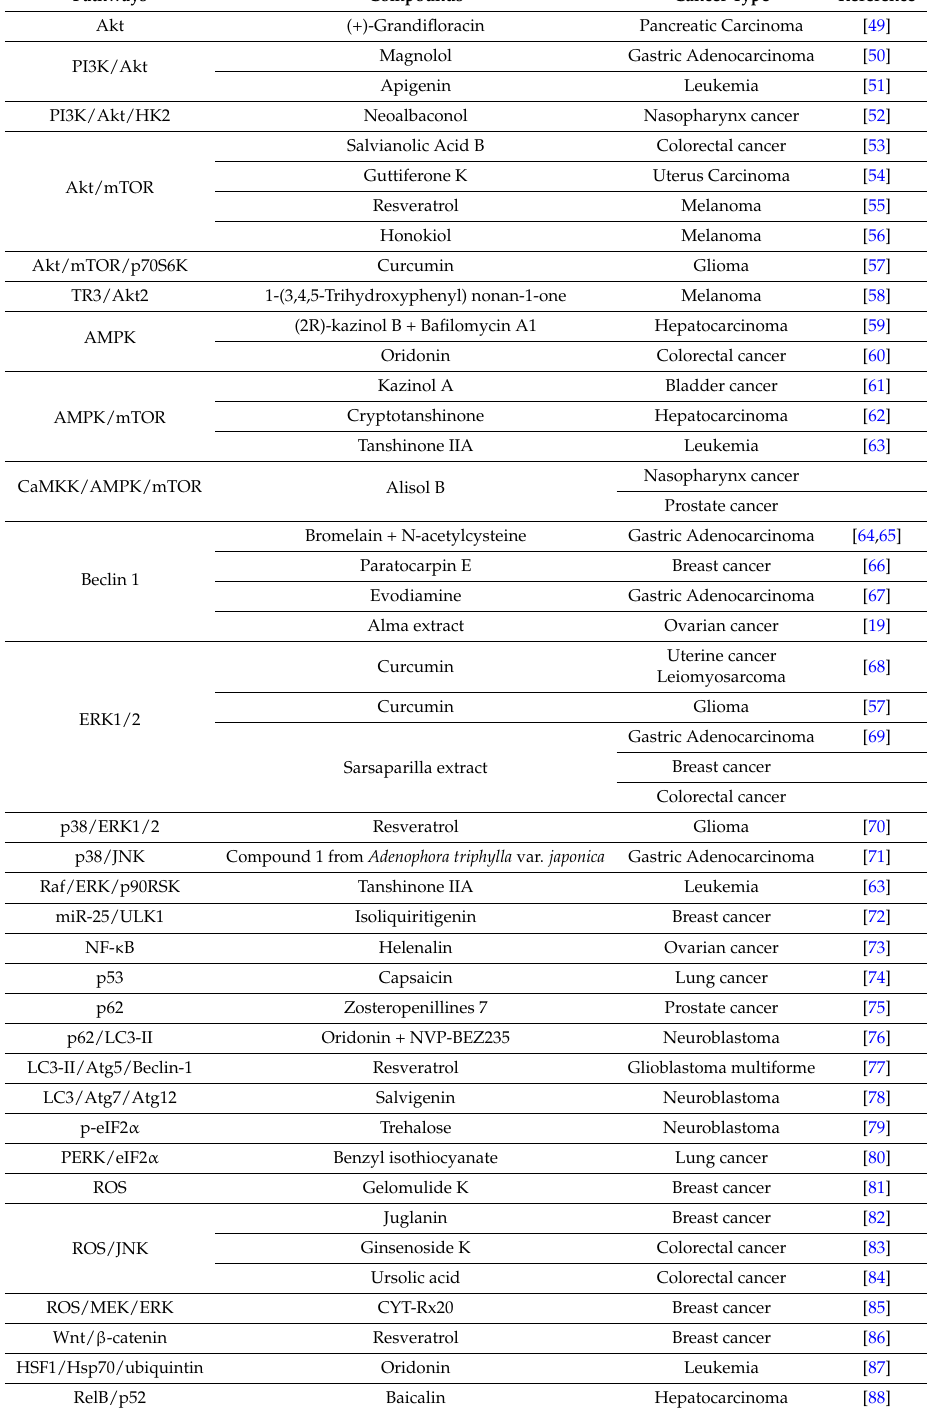
Table 2. Natural autophagy inducers and their effect on signal transduction